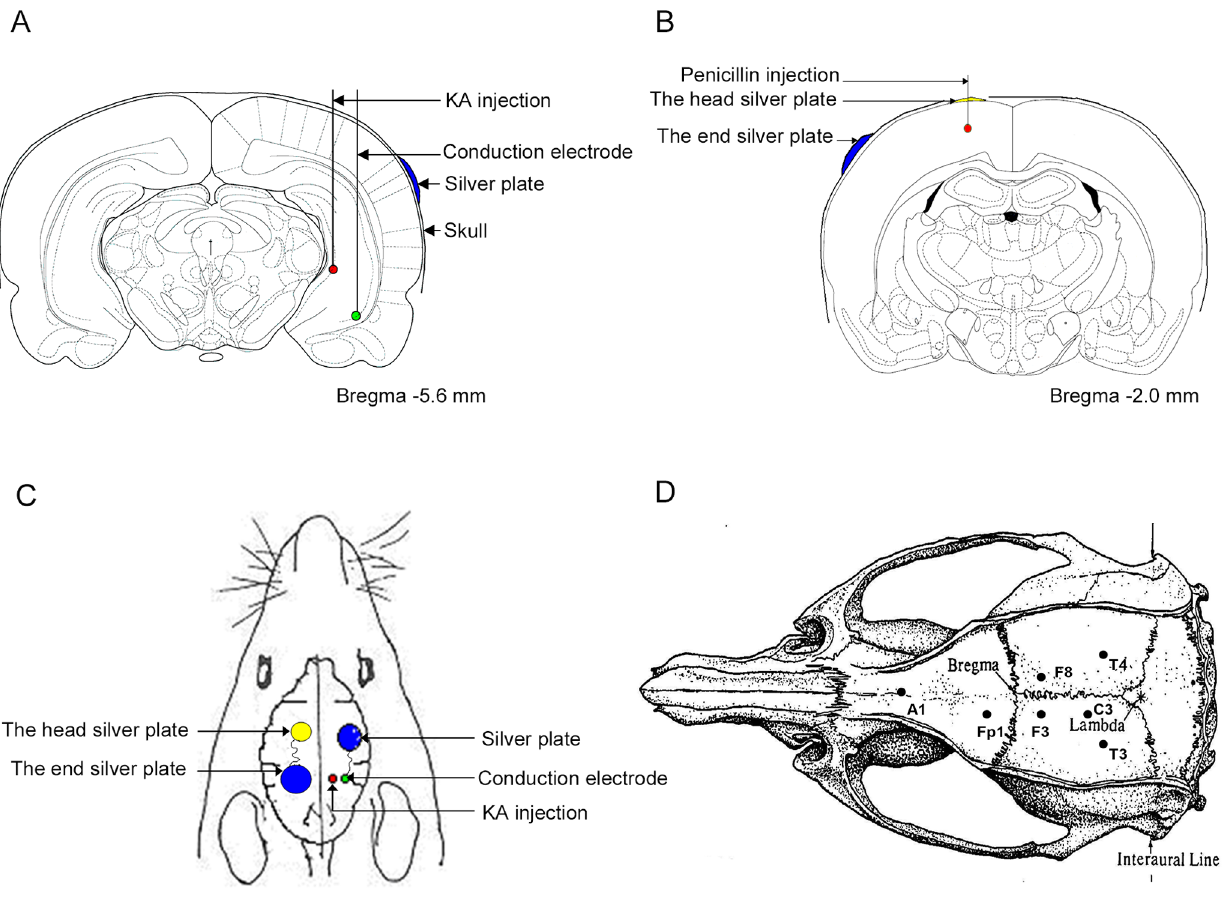
Figure 2. The position of drug injection and electrodes implantation. (A) and (C): Red, KA injection site, and the tip of the recording electrode for the CA3 region of the right hippocampus; Green, the tip of the conduction electrode; and Blue, the end of the conduction electrode, a silver plate. (B) and (C): Red, penicillin injection site; Yellow, the head end of conduction electrode; and Blue, the tail end of conduction electrode. (D) Diagram of the placement of implanted recording electrodes. The EEG signals were recorded from F4, T4, and T3 electrodes in KA rats, and Fp1, F3 and C3 electrodes in penicillin rats against the reference electrode A1 (adapted from Paxinos & Watson, 1997 [19]).